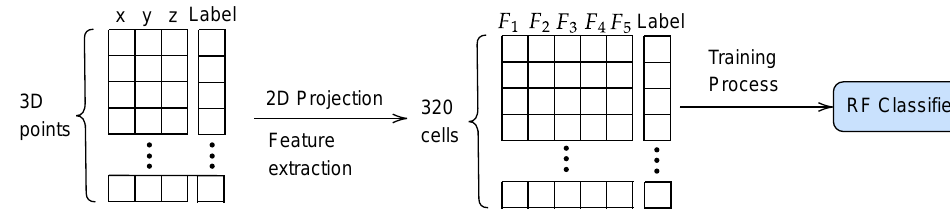
Figure 2. Pipeline for training the RF cell classifier.